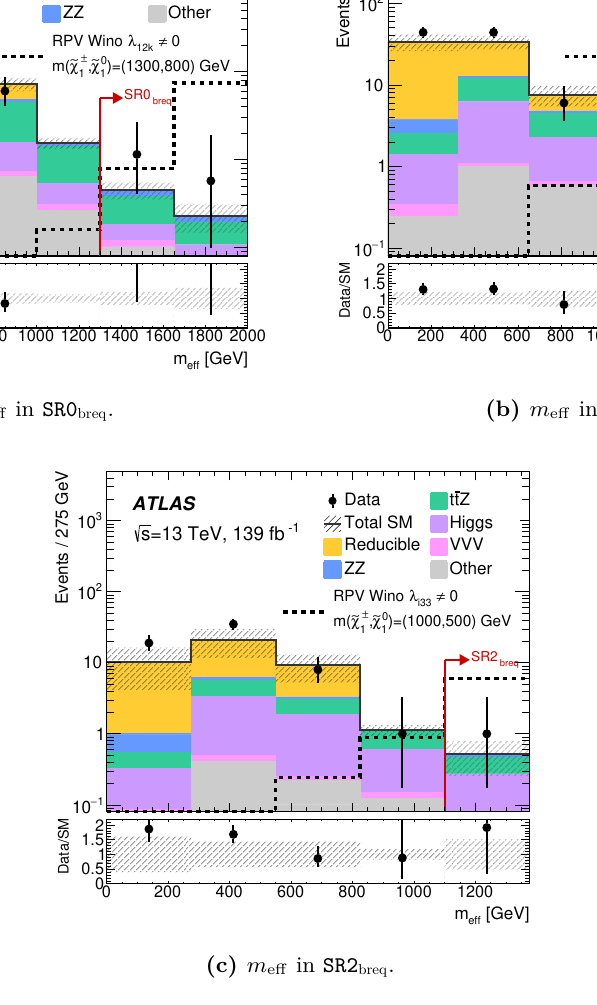
Figure 10. The m eff distribution in (a) SR0 breq , (b) SR1 breq , and (c) SR2 breq for events passing the signal region requirements except the m requirement. Distributions for data, the estimated SM eff backgrounds after the background-only fit, and an example SUSY scenario are shown. “Other” is the sum of the tWZ , t ¯ tWW , t ¯ tZZ , t ¯ tWZ , t ¯ tWH , t ¯ tHH , t ¯ ttW , and t ¯ tt ¯ t backgrounds. The last bin captures the overflow events. The lower panel shows the ratio of the observed data to the expected SM background yield in each bin. Both the statistical and systematic uncertainties in the SM background are included in the shaded band. The red arrows indicate the m selections in the eff signal and validation